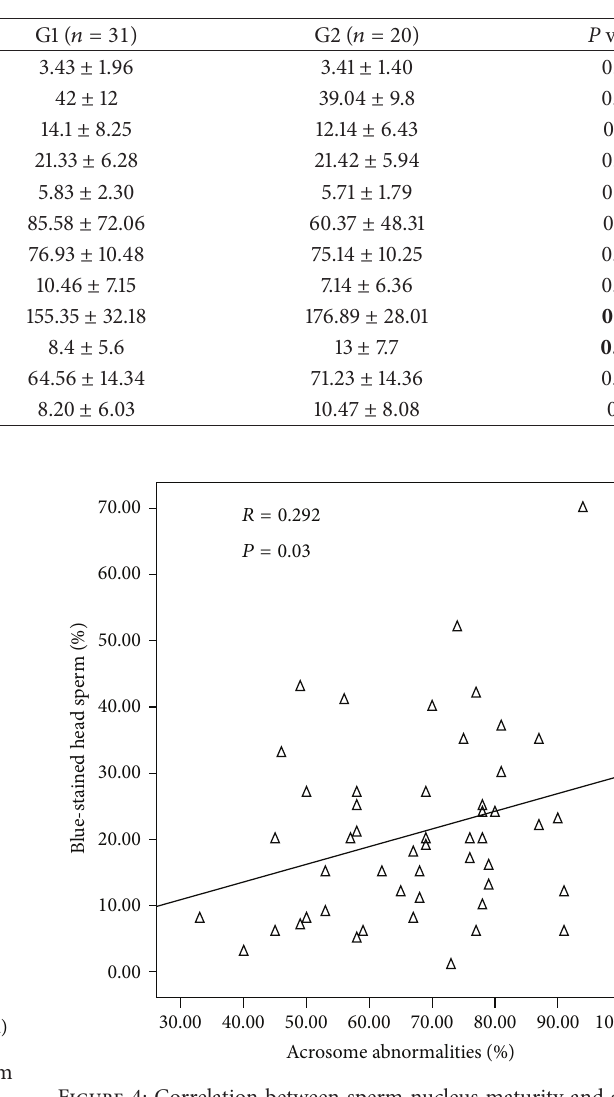
Table 2: Comparison of semen parameters between G1 and G2 groups.